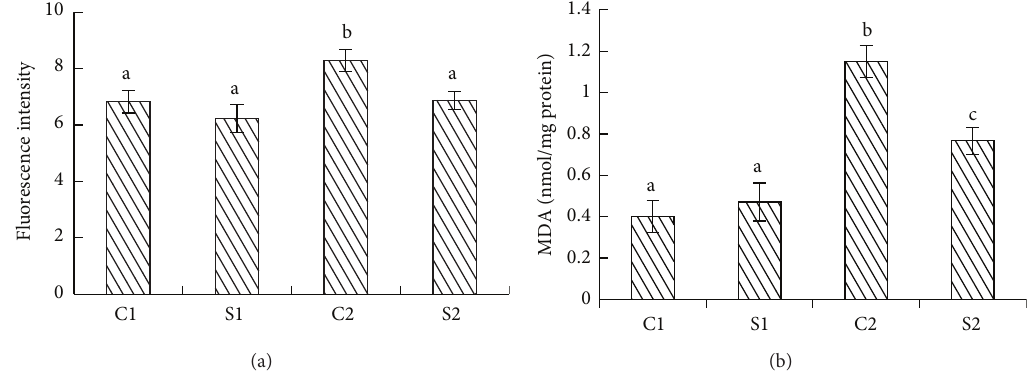
Figure 3: Effects of MKAVCFSL on (a) intracellular ROS level and (b) MDA concentration C1: control 1, medium treatment without H and peptide; S1: sample 1, peptide treated only; C2: control 2, H 2 O 2 treated only; S2: sample 2, medium treatment with H 2 O 2 and peptide. ROS level was expressed as fluorescence intensity. Results are the means ± SD from three independent experiments. Different small letters indicate significant differences between groups ( p < 0 .